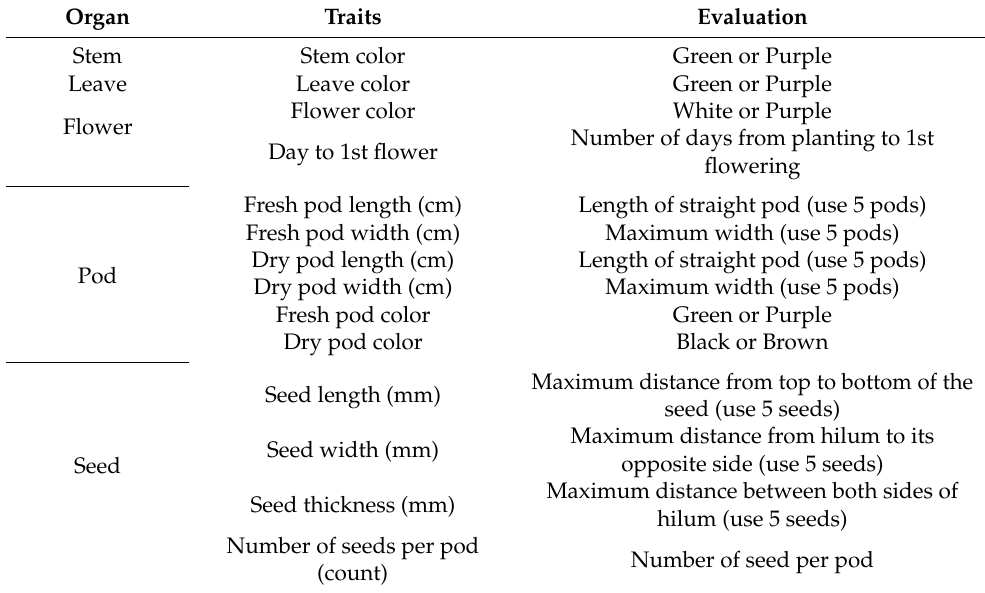
Table 7. Details of 14 morphological traits evaluated in the 493 lablab accessions. Organ